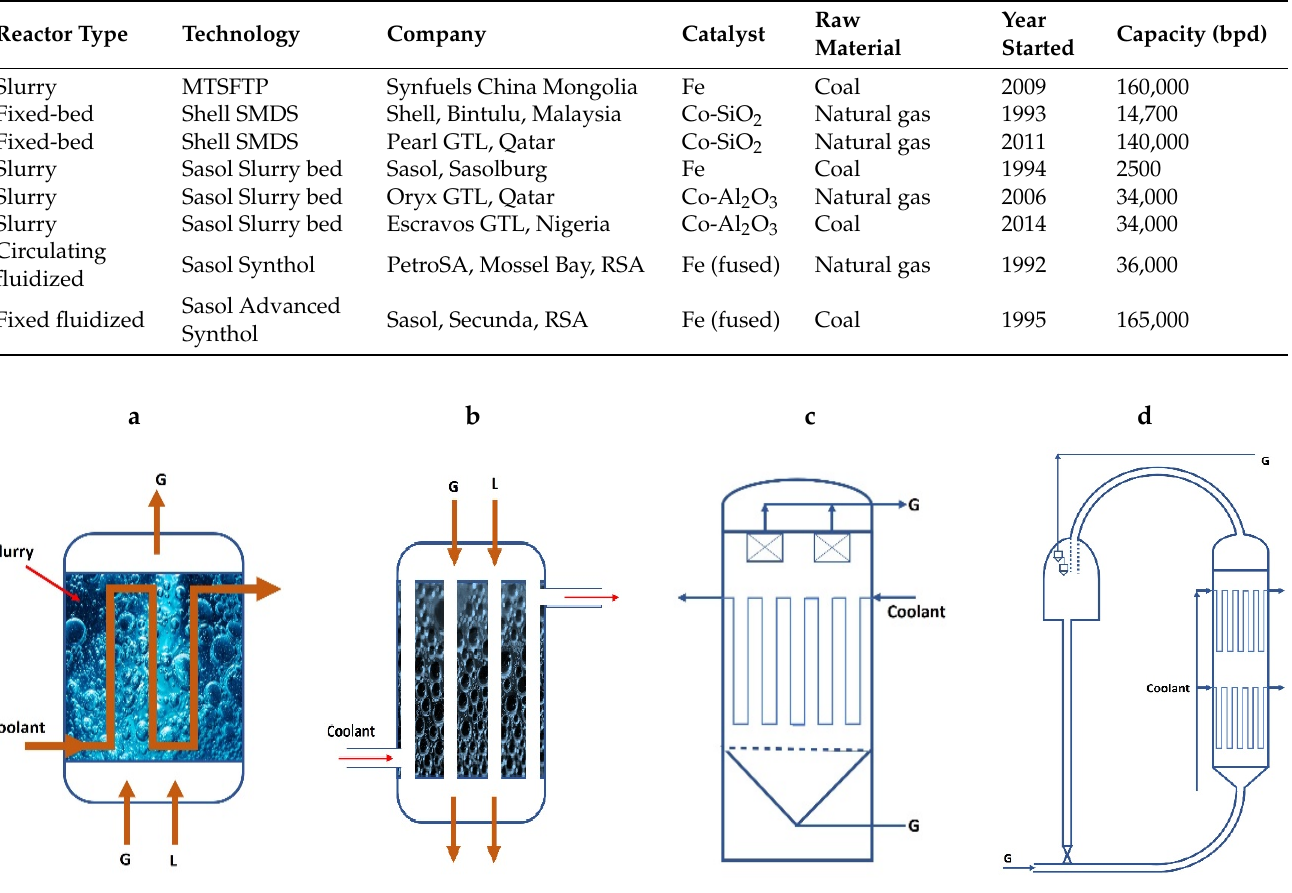
Figure 4. Possible reactors for Fischer–Tropsch synthesis [93,99]: ( a ) Slurry bubble column reactor; ( b ) Multi-tubular trickle bed reactor; ( c ) circulating fluidized bed reactor; ( d ) fluidized bed reactor.